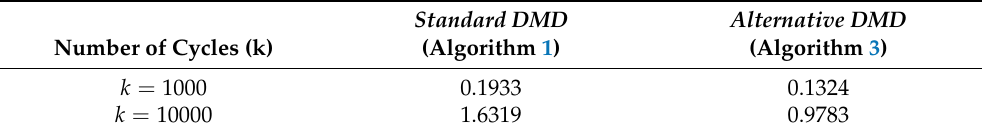
Table 8. Execution time (in sec.) by Algorithms 1 and